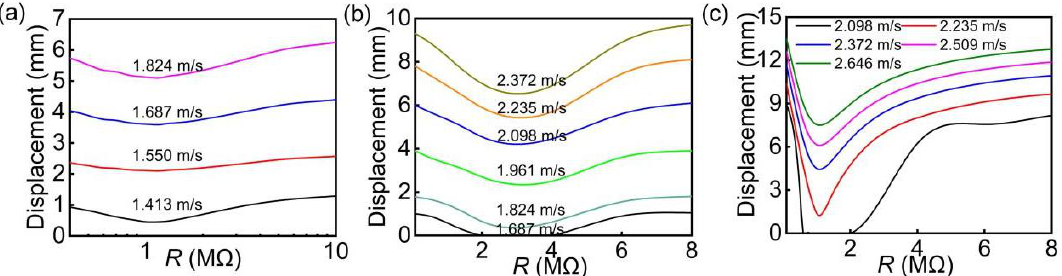
Figure 8. Variation of numerical displacement with the load resistance: ( a ) weak coupling k 2 /(4 ζ + 4 ζ 2 ) = 0.029; ( b ) critical coupling k 2 /(4 ζ + 4 ζ 2 ) = 1; ( c ) strong coupling k 2 /(4 ζ + 4 ζ 2 ) = 2.9.